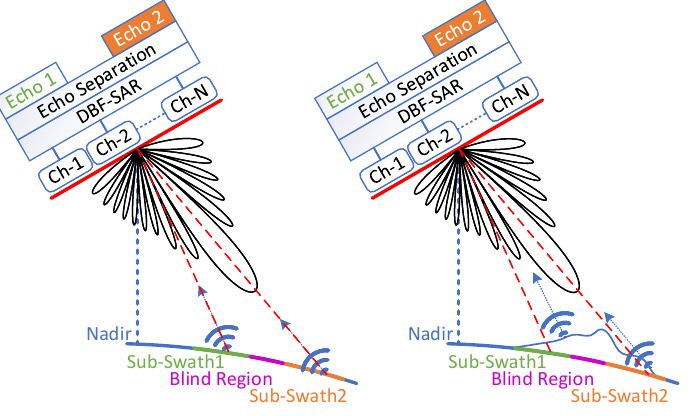
Figure 5. Diagram of the the effect of undulating terrain on the DBF reception